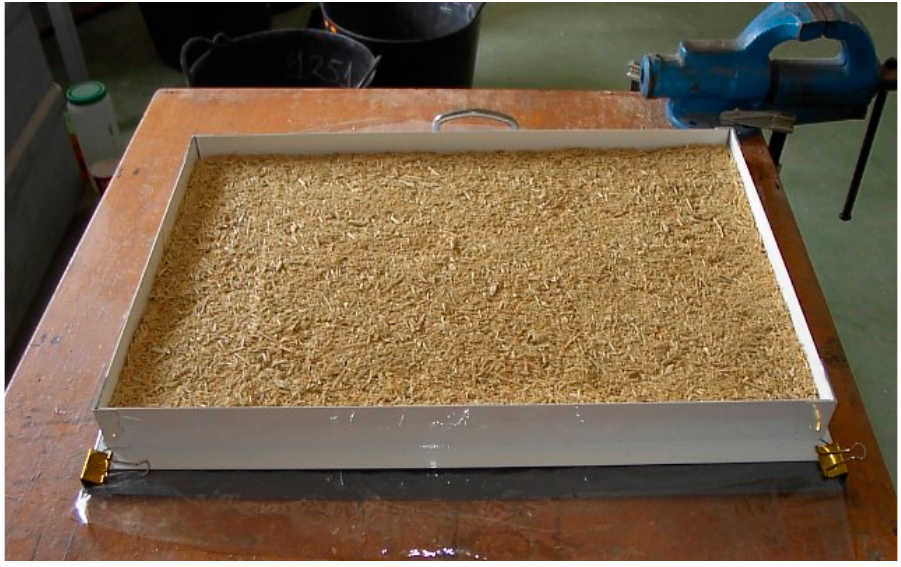
Figure 3. Mat formed manually to manufacture the particleboards.